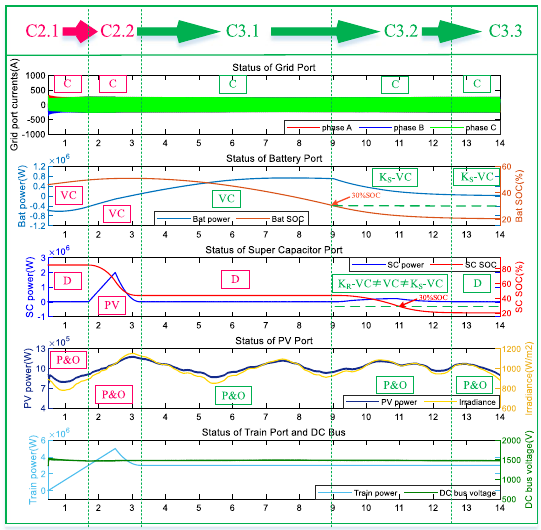
Fig. 14 Simulation waveform diagram of each port of the typical working condition switching under the constant power of the